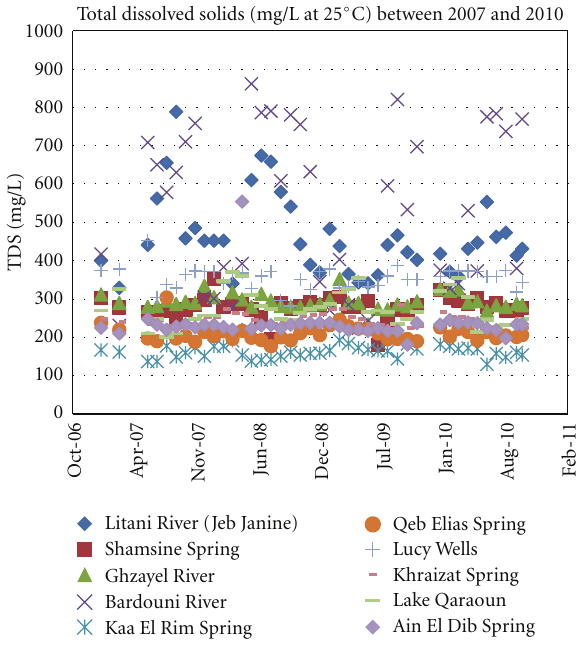
Figure 4: Recorded total dissolved Solids concentrations for years 2007 through 2010.